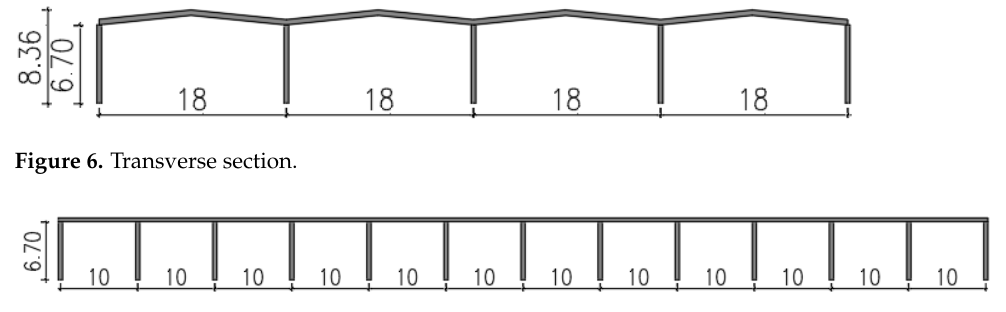
Figure 7. Longitudinal section.